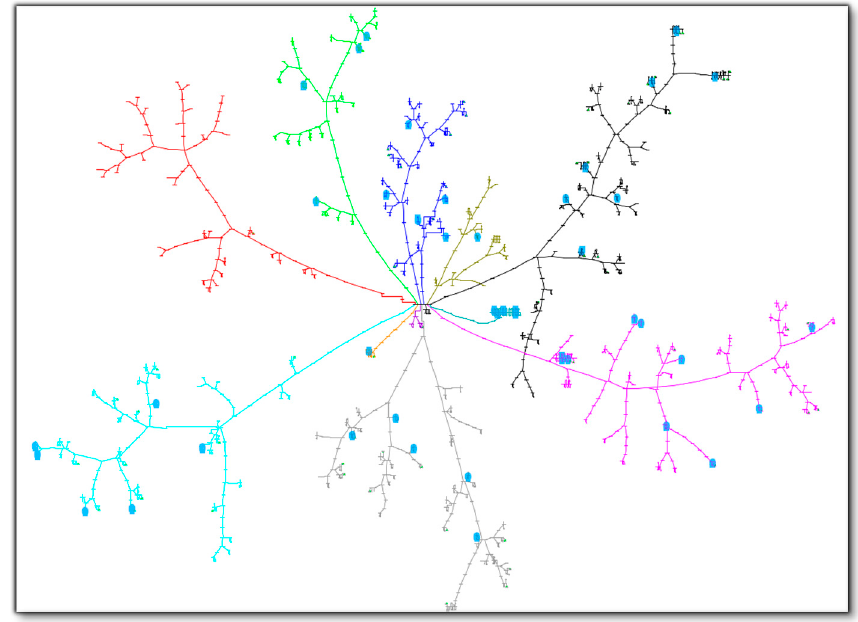
Figure A6. Use case 3—Location of PVs.